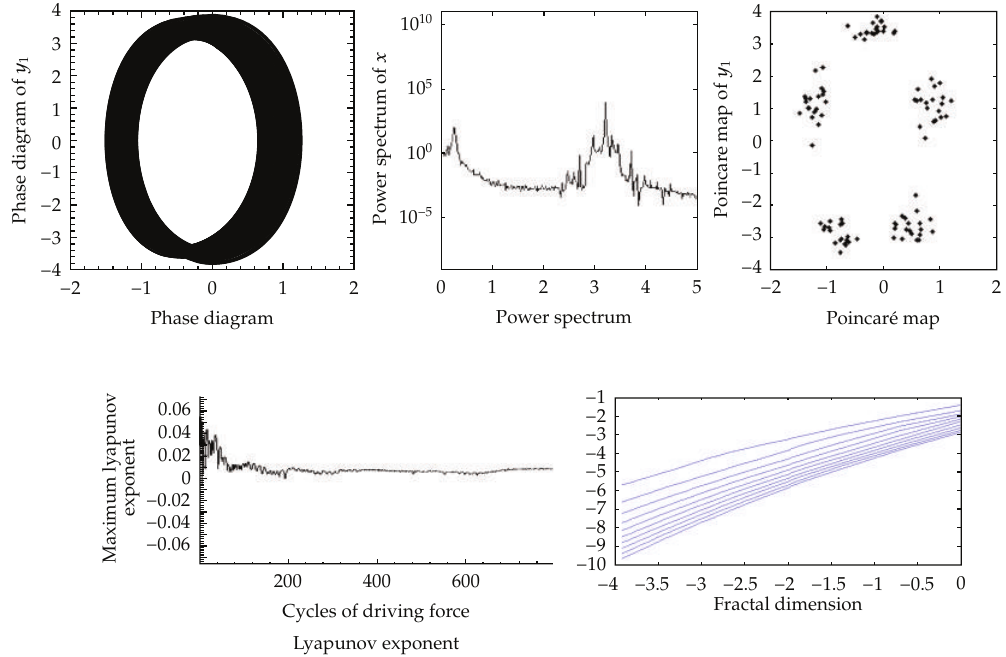
Figure 7: Simulation results obtained for gear-bearing system with s (cid:9) 0 . 8 for y 1 (cid:6) l ∗ (cid:9) 0 . 3 (cid:7) .